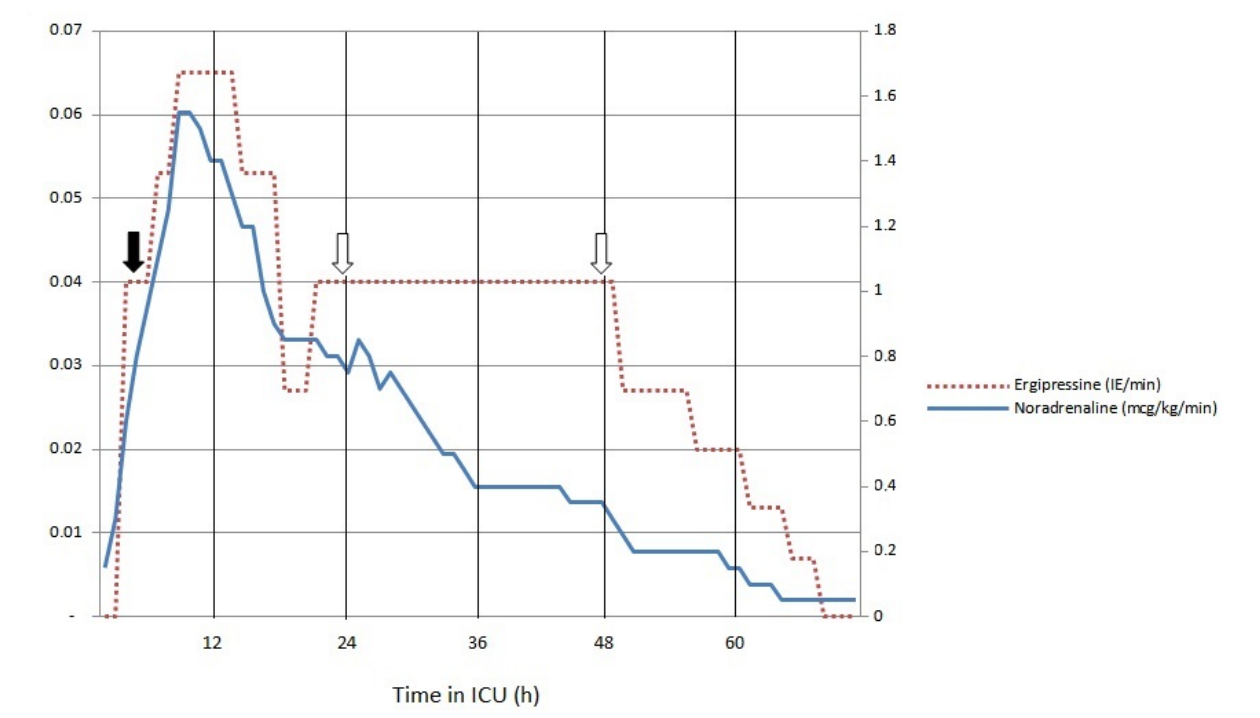
Figure 1. Vaspressor doses in the first 72 h of ICU treatment (solid arrow represents the start of cytokine removal and empty arrows represent the timepoints of hemadsorption membrane changes).